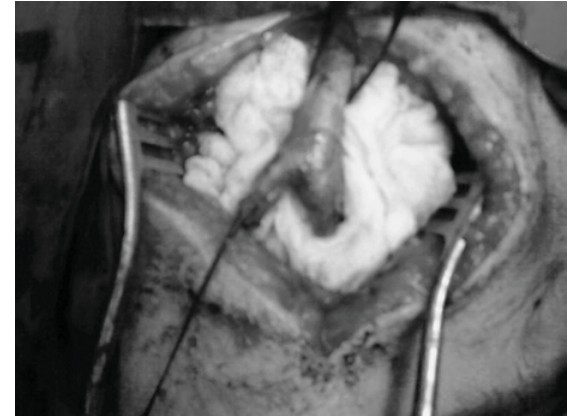
Figure 6. Histopathological examination of the tumor